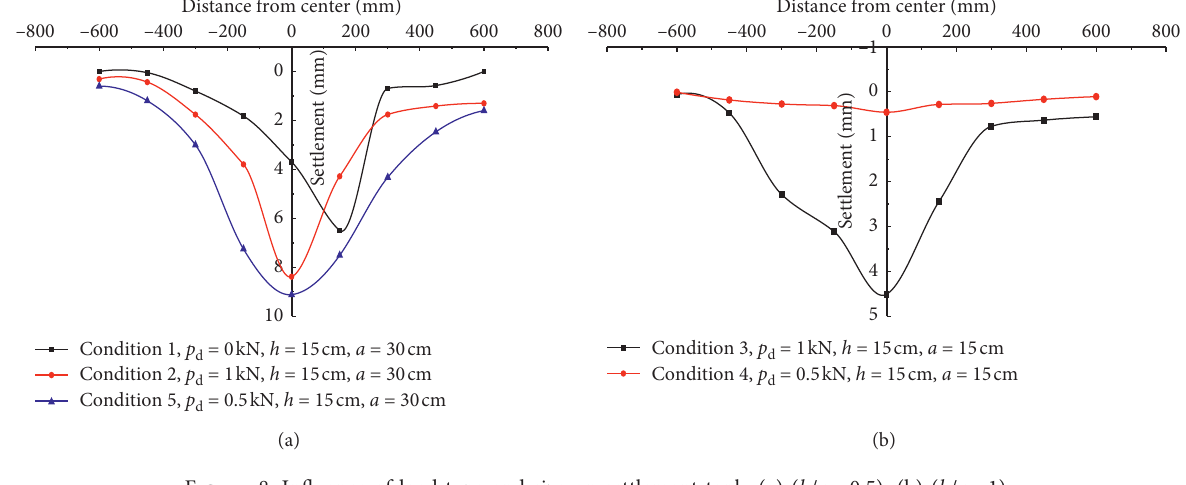
Figure 8: Influence of load type and size on settlement tank. (a) ( h / a � 0.5). (b) ( h / a �